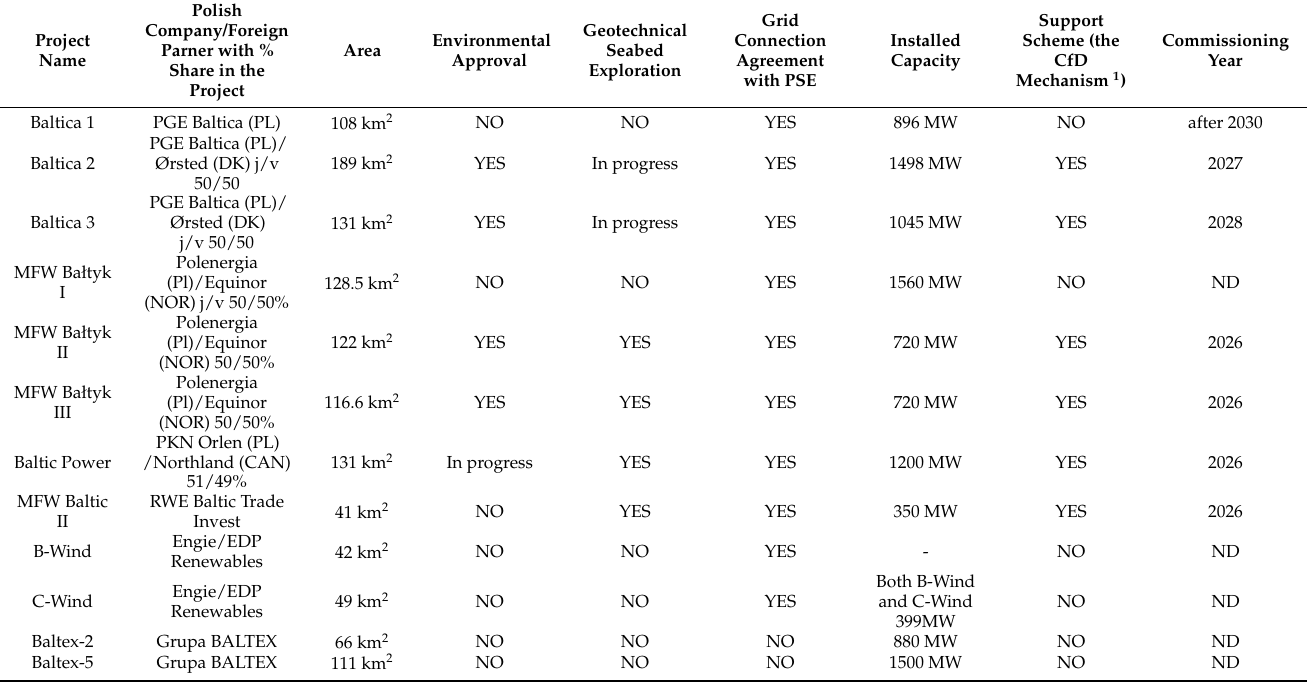
Table 2. Offshore wind projects in Poland (end of June